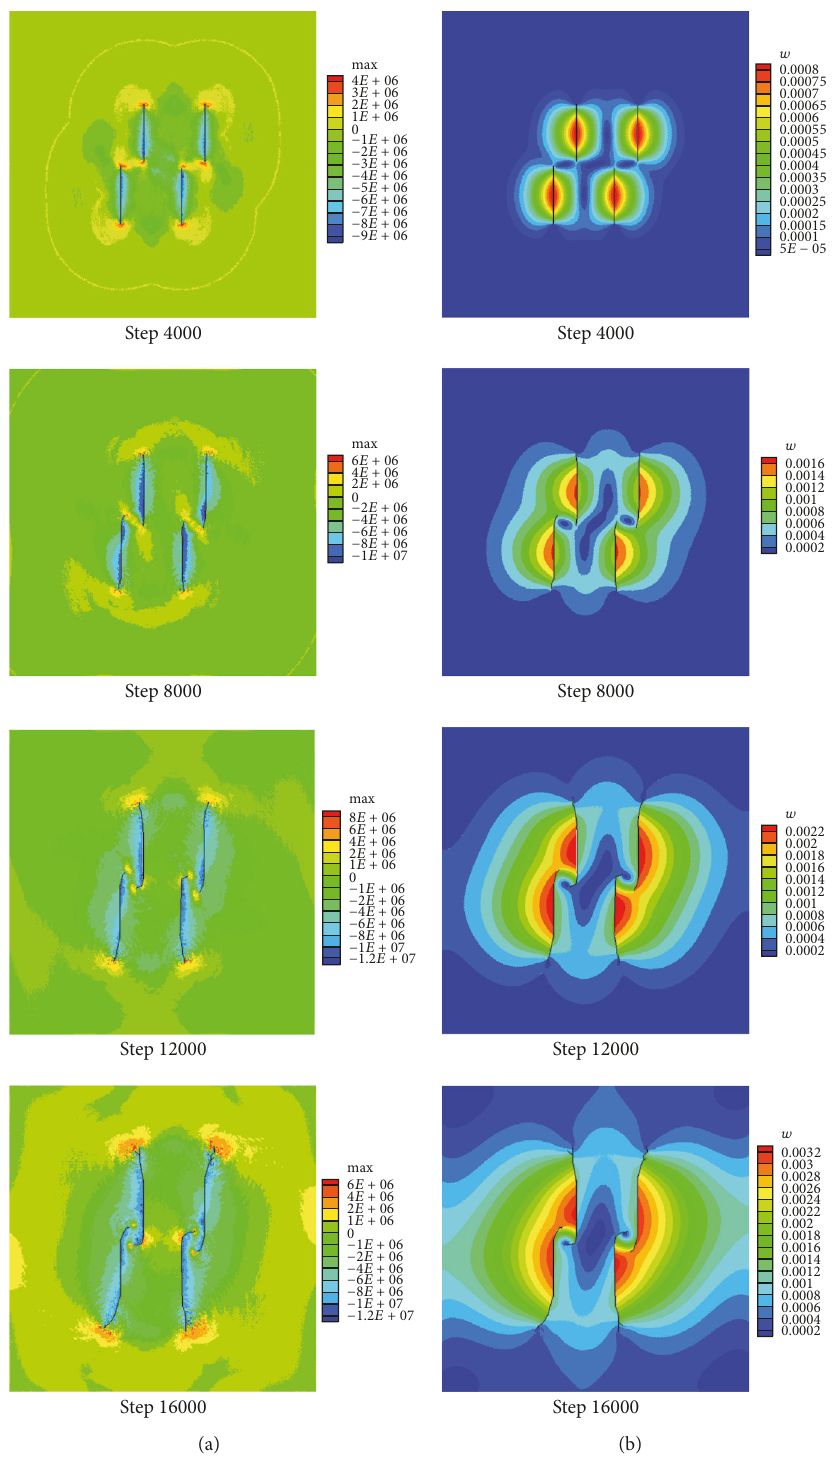
Figure 29: Counter of (a) maximum principle stress and (b) displacement